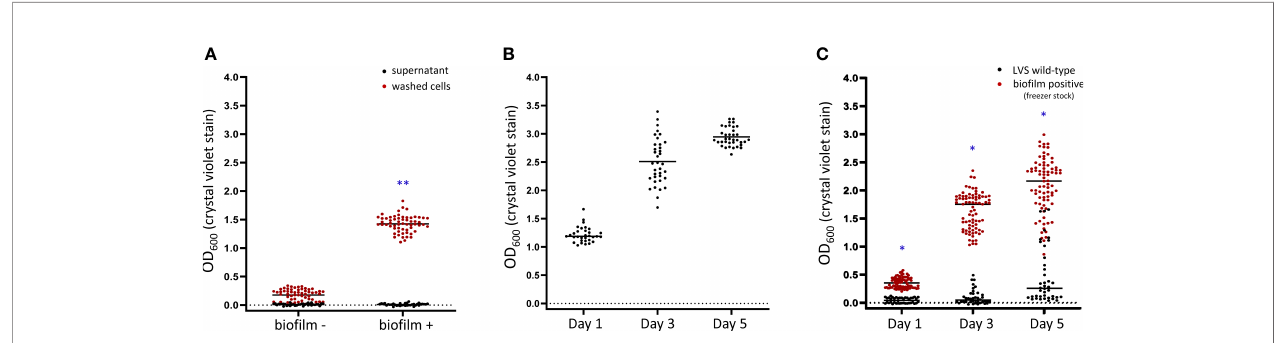
FIGURE 6 | An inherent cell associated trait is responsible for bio fi lm formation in F. tularensis . (A) LVS was cultured for 7 days in CDM after which the contents of a bio fi lm negative and bio fi lm positive wells were separated into sterilized supernatant or repeatedly washed cells. The sterilized supernatant was applied to naïve cells and the ability to form bio fi lm was compared to washed cells only using crystal violet staining. The bio fi lm capacity of the (B) washed cells or (C) frozen bio fi lm positive stocks was assayed at 1, 3 and 5 days post-inoculation. Black bars indicates the median. *P < 0.05; **P